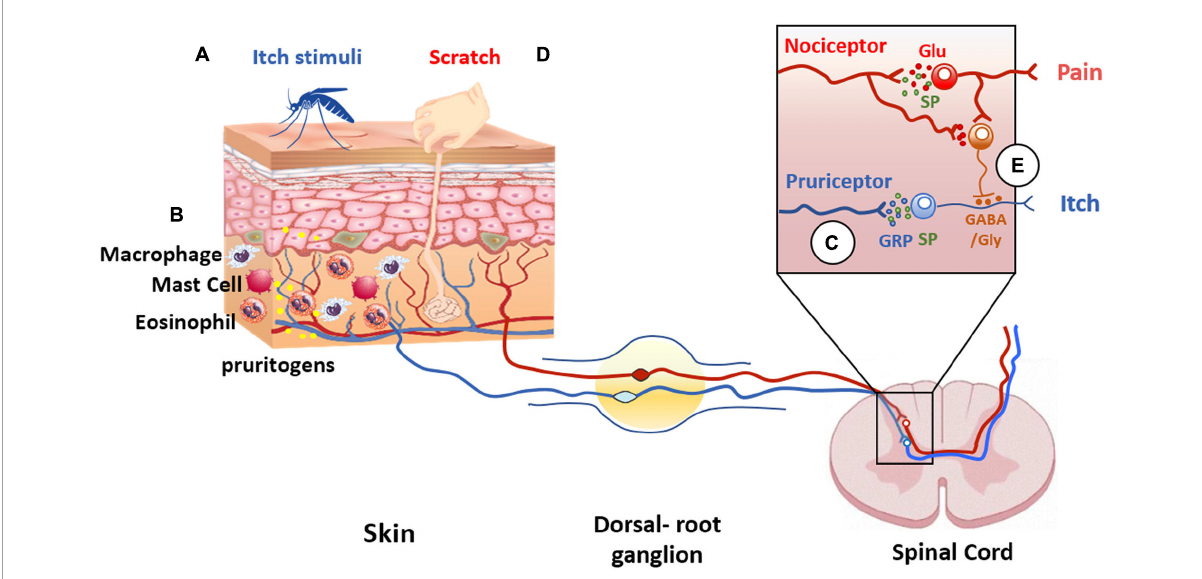
FIGURE4 Itch and pain pathway interaction. Pruritogens (A) initiate itch sensation via pruriceptors (blue line) activation present in cutaneous sensory neurons. (B) In addition, other cell types are involved in itch signaling, such as keratinocytes, or innate immune cells that release pruritogens (yellow dots) such as histamine and IL-31, leading to the activation of pruriceptors and induction of peripheral sensitization. (C) The intraspinal terminals of pruriceptors (blue line in insert) release gastrin releasing peptide (GRP) (blue dots) and/or substance P (SP) (green dots) as neuropeptide transmitters to excite post-synaptic neurons expressing GRP and/or NK-1 receptors. (D) Scratching the skin presumably activates mechanically sensitive C-fiber polymodal nociceptors with primary afferent projections to the superficial dorsal horn of the spinal cord (red line). These afferents release glutamate to excite inhibitory interneurons in the superficial dorsal horn resulting in inhibition of the itch pathway (E) . The inhibitory interneurons use glycine and GABA as neurotransmitters to inhibit pruritogen-responsive neurons (orange